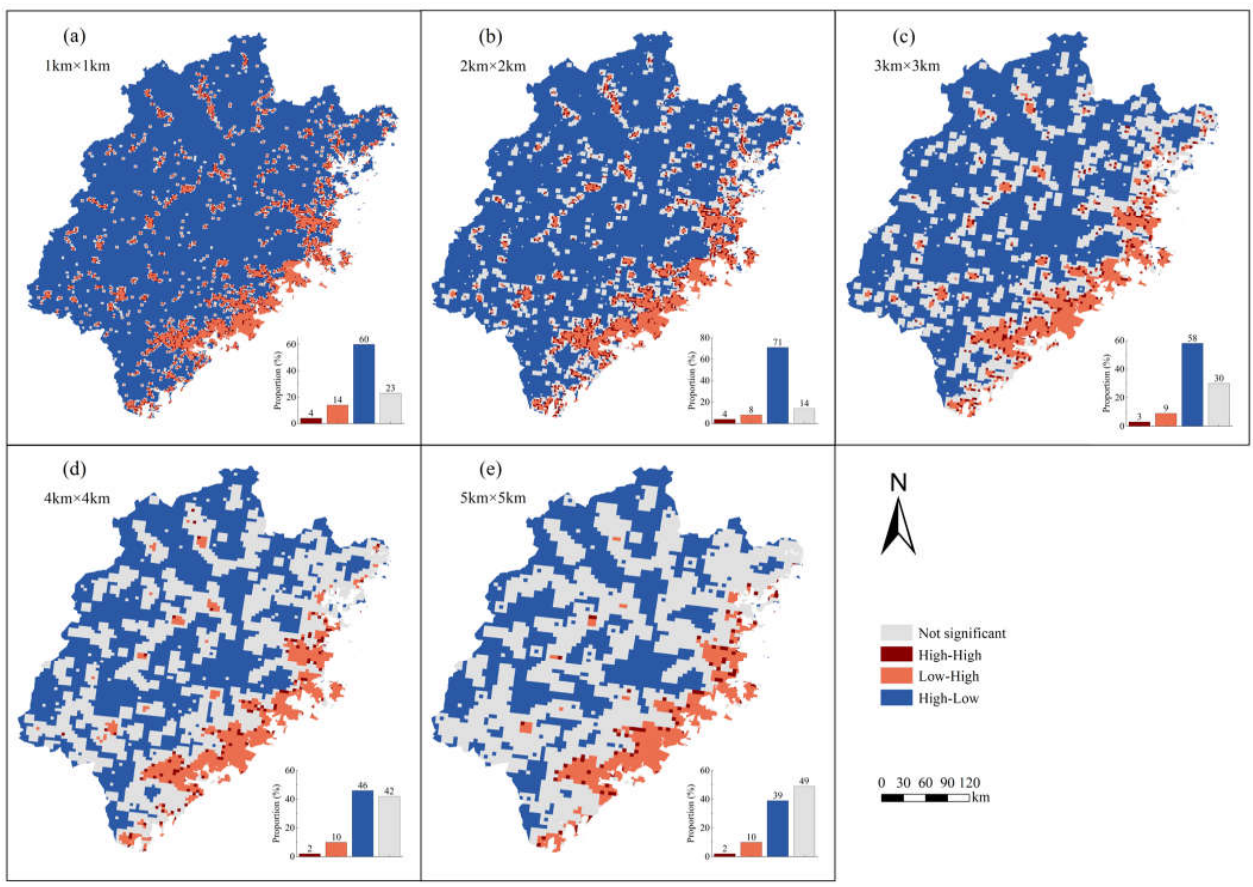
Figure 4. LISA maps between greening and browning at 1 km × 1 km ( a ), 2 km × 2 km ( b ), 3 km × 3 km ( c ), 4 km × 4 km ( d ) and 5 km × 5 km ( e ) scale. The proportion of clustering type at different scale was draw in the bottom-right for each panel.